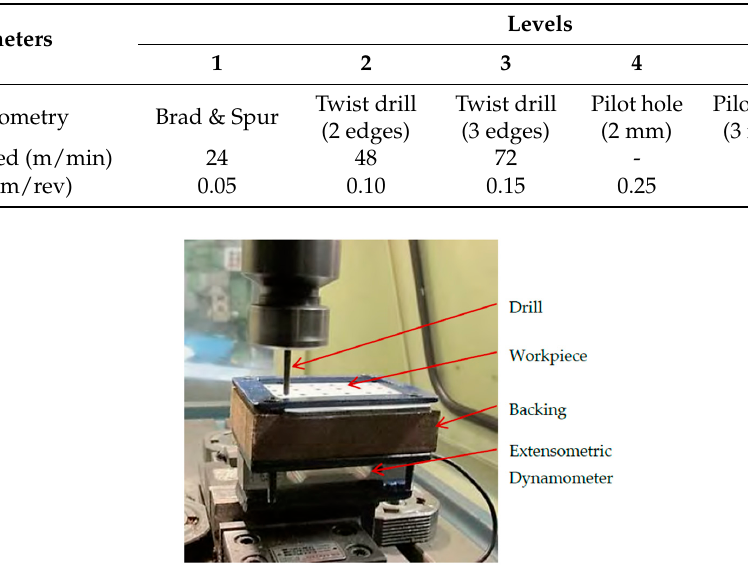
Figure 4. Experimental set-up for the drilling tests.